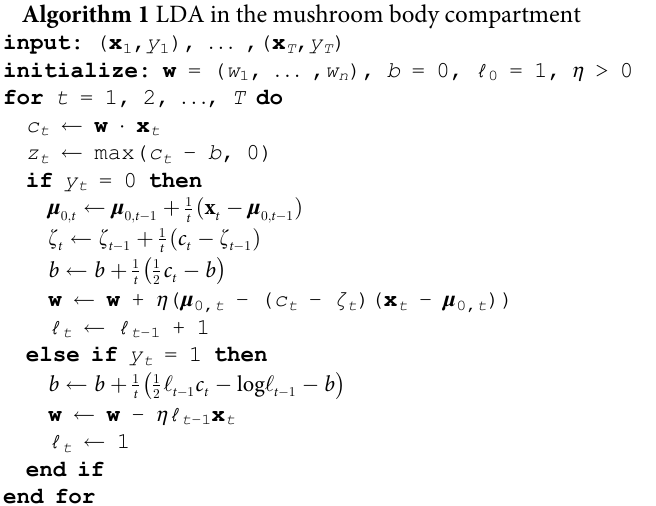
Algorithm 1 LDA in the mushroom body compartment